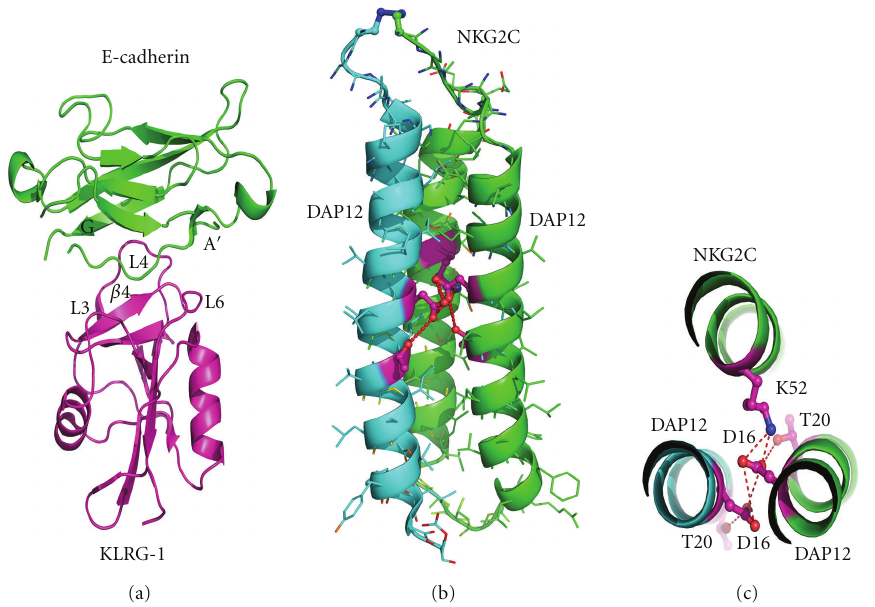
Figure 9: (a) Structure of KLRG1 in complex with E-cadherin shown in cartoon representation with the critical KLRG-1 loop regions which interact with the E-cadherin A (cid:3) and G sheet regions labeled. (b) Cartoon representation of the heterotrimeric NKG2C DAP12 transmembrane complex with interacting residues shown in ball and stick representation with bonding network shown by dashed lines. (c) View from above the membrane showing a closeup of the interacting residues and bonding